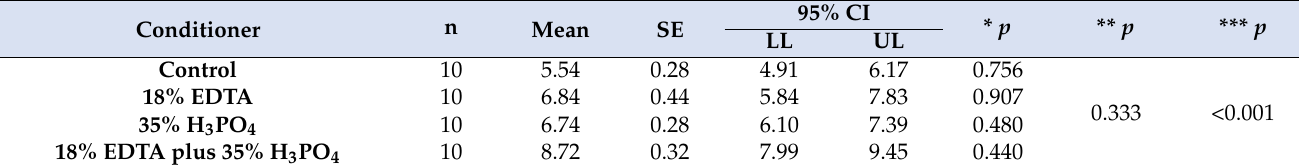
Table 2. Comparison of adhesive strength (MPa) according to type of conditioner